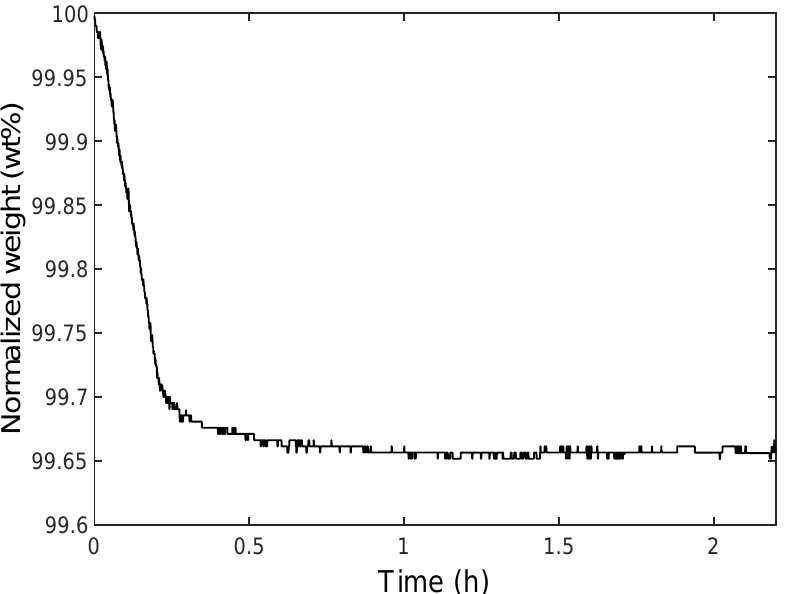
Figure 2. Thermogram of the normalized weight of the fully rehydroxylated particles in acid, heated at 150 ◦ C for 2 h. The mass loss corresponds only to the physically adsorbed water at the surface of the particles since the onset of dehydroxylation has not been reached